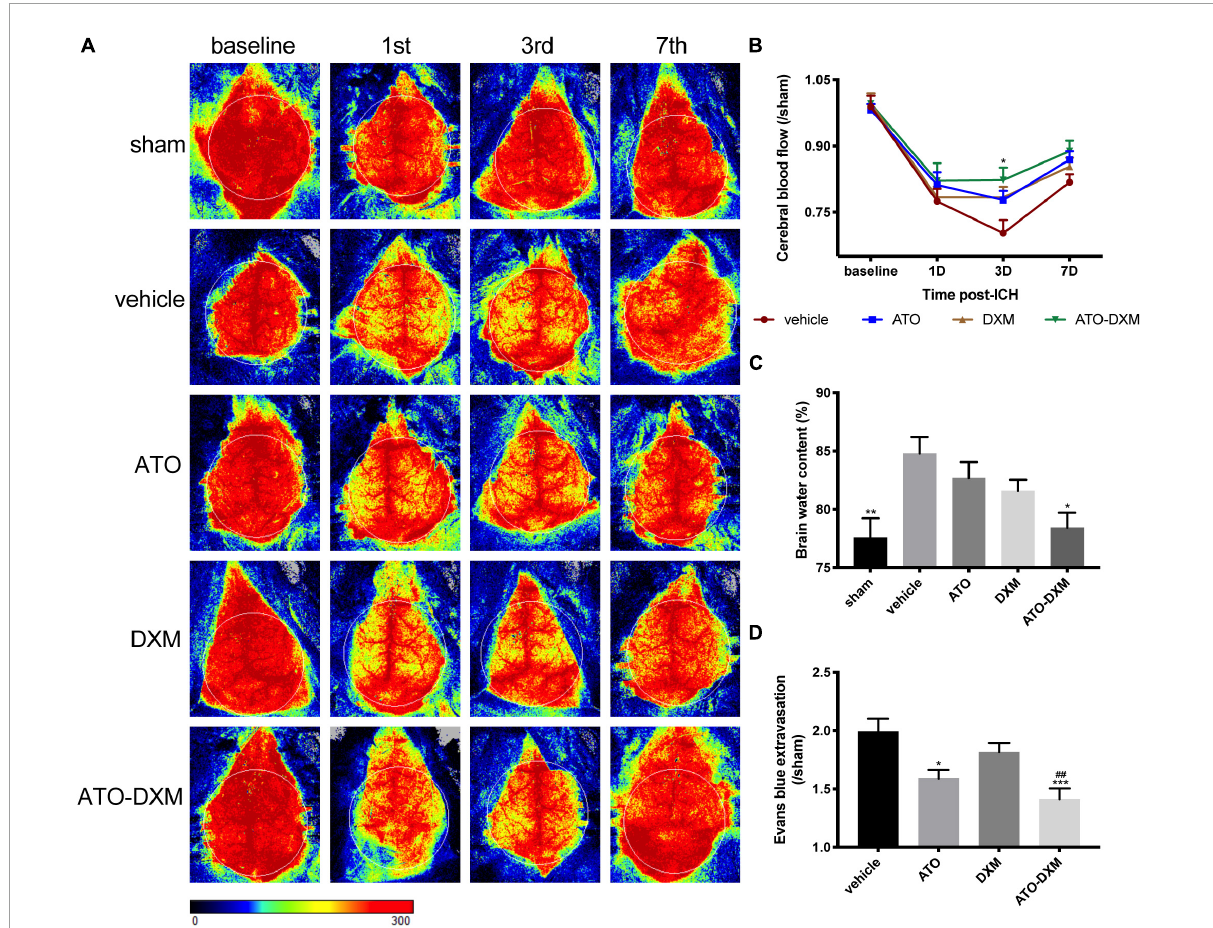
FIGURE5 Evaluation of CBF, brain edema, and BBB integrity after ICH. (A) Representative images of CBF changes at baseline, 1, 3, and 7 days after ICH for each group. (B) Trend and statistical comparison of CBF in each group after ICH. Results were expressed as a ratio of each group compared to the sham group. (C) Brain water content on day 3 after ICH. (D) BBB integrity was evaluated by Evans blue extravasation on day 3 after ICH. * p < 0.05, ** p < 0.01, *** p < 0.001 vs. vehicle group. ## p < 0.01 vs DXM